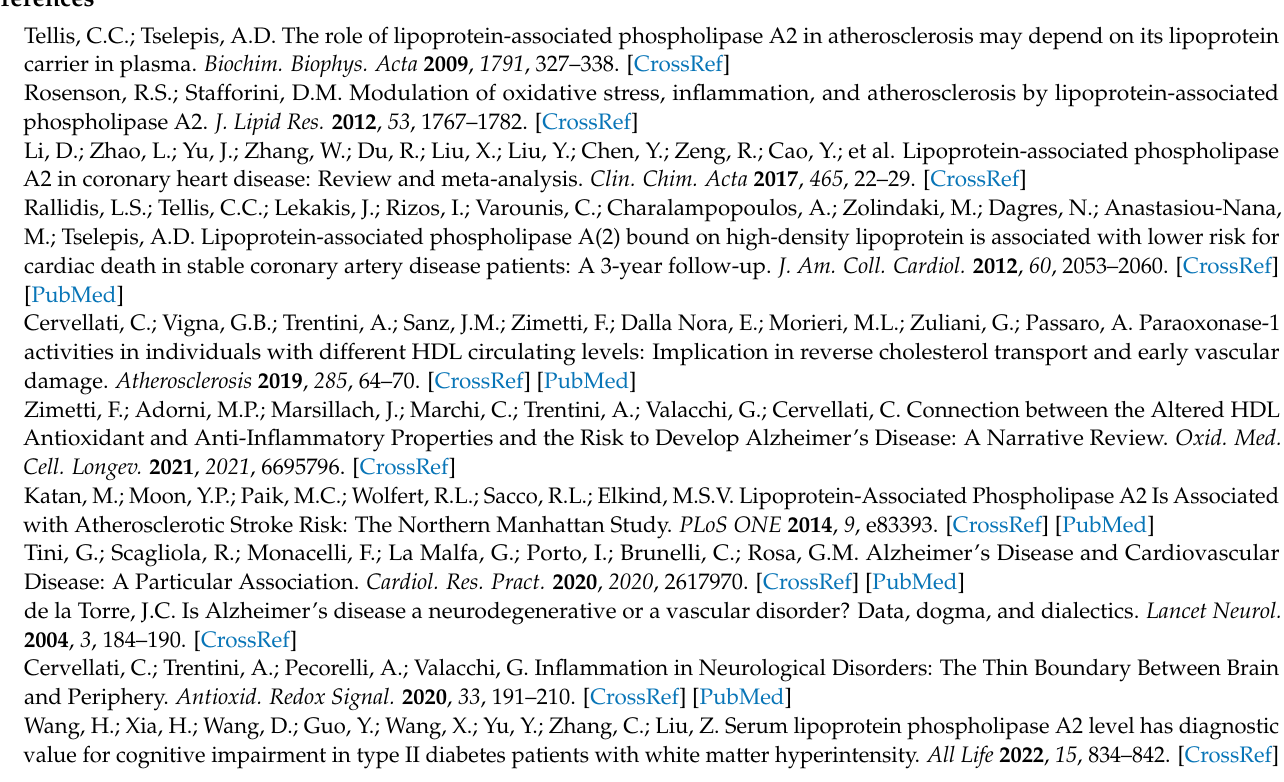
activity levels and age; Figure S3: Correlation between serum Lp-PLA2 activity levels and sex; Figure S4: Correlation between serum Lp-PLA2 activity levels in healthy individuals and patients with CVD; Figure S5: Correlation between serum Lp-PLA2 activity levels in healthy individuals and patients with diabetes. Table S1: Levels of serum Lp-PLA2 activity in Controls, MCI, AD, VAD, MIXED AD-VAD, and Dementia subtypes after exclusion of younger